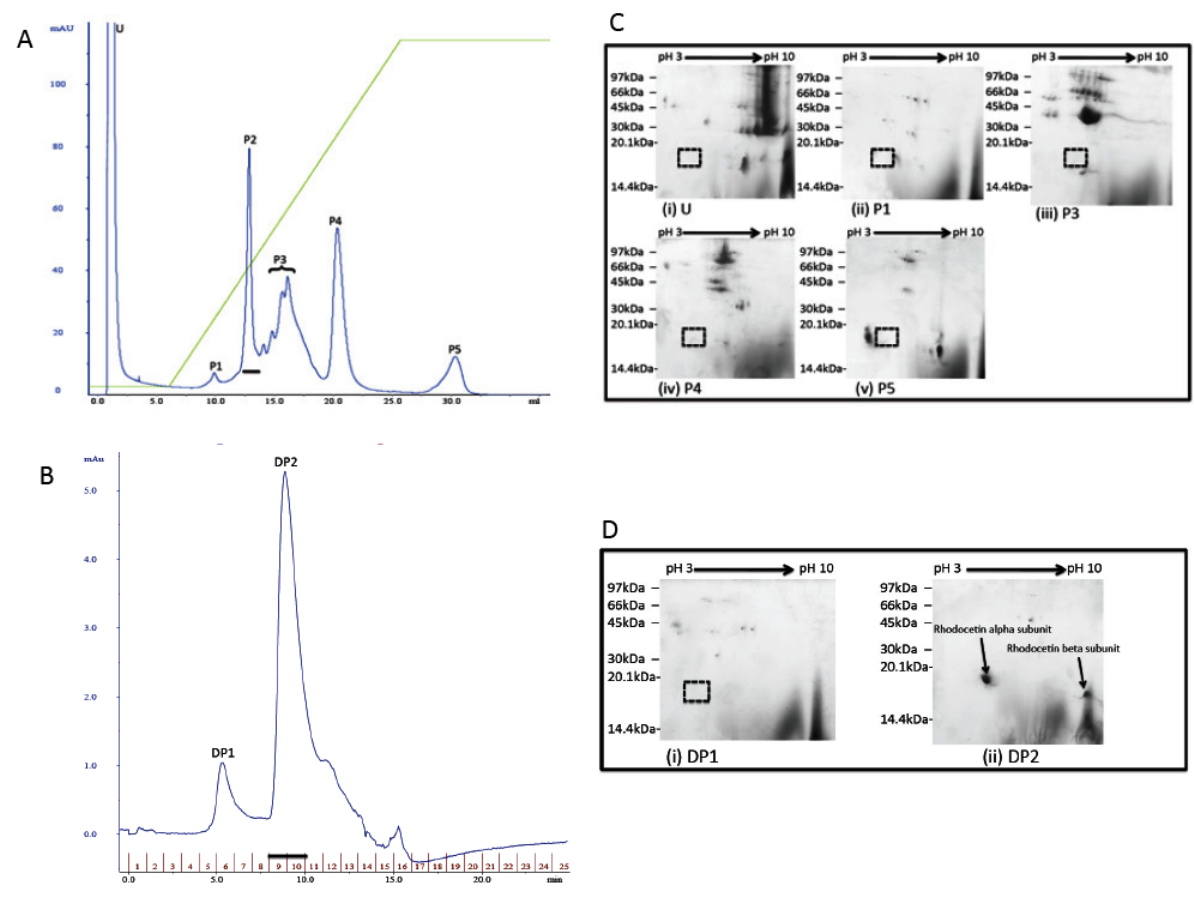
Figure 2. Purification profiles of rhodocetin from CR and the 2DE profiles for each peak obtained from the two-stage purification protocol. The horizontal bars indicate the collected fractions containing rhodocetin. The black grids represent our area of interest in which the rhodocetin (α subunit) spot should have been present. ( A ) Five milligram of crude CR venom dissolved in 250 m L of 20 mM Tris-HCl, pH 8.5 and loaded into a Mono Q 5/50 GL® (1 mL) column, equilibrated with 20 mM Tris-HCl, pH 8.5. Six peaks were obtained. ( B ) The P2 fraction collected from the Mono Q column was directly injected into a G25 HiTrap Desalting® column, equilibrated with distilled water. Two peaks, DP1 and DP2, were obtained. ( C ) Two-dimensional gel electrophoresis was performed on five peaks obtained from the anion-exchange separation and the profiles clearly displayed. 2DE assay was not performed on peak P2 as it was directly injected into the G25 HiTrap Desalting column without prior lyophilisation. ( D ) Two-dimensional gel electrophoresis profile of DP2 clearly showing the presence of rhodocetin α and β